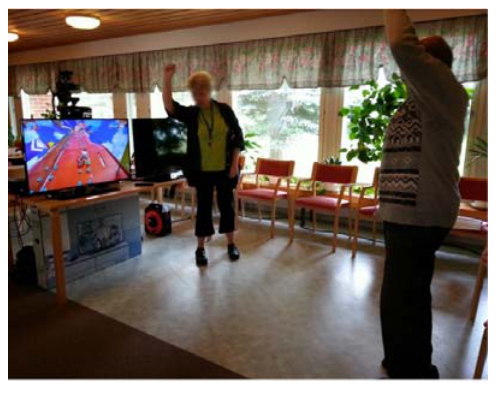
Figure 2. A Pilot User Testing at Rääkkylä